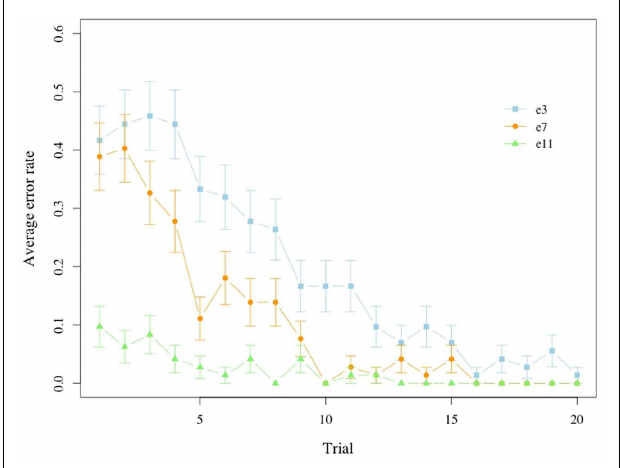
FIGURE 4 | Error rate by period. Average error by type for G (15, 3).